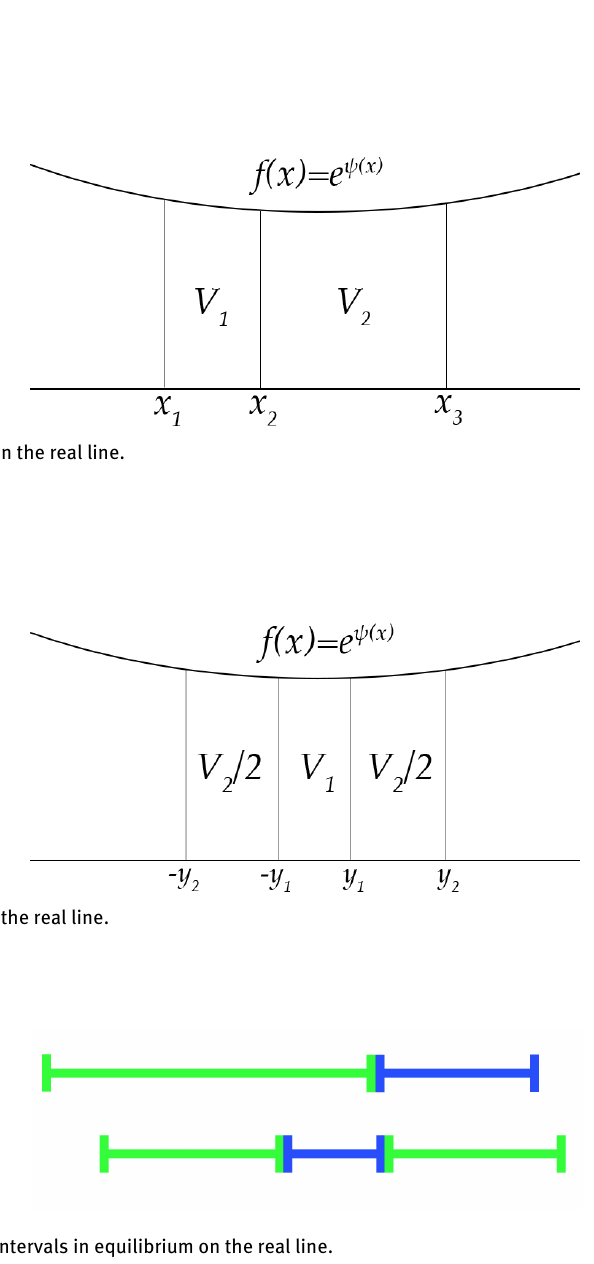
Figure 8: Double and triple intervals in equilibrium on the real